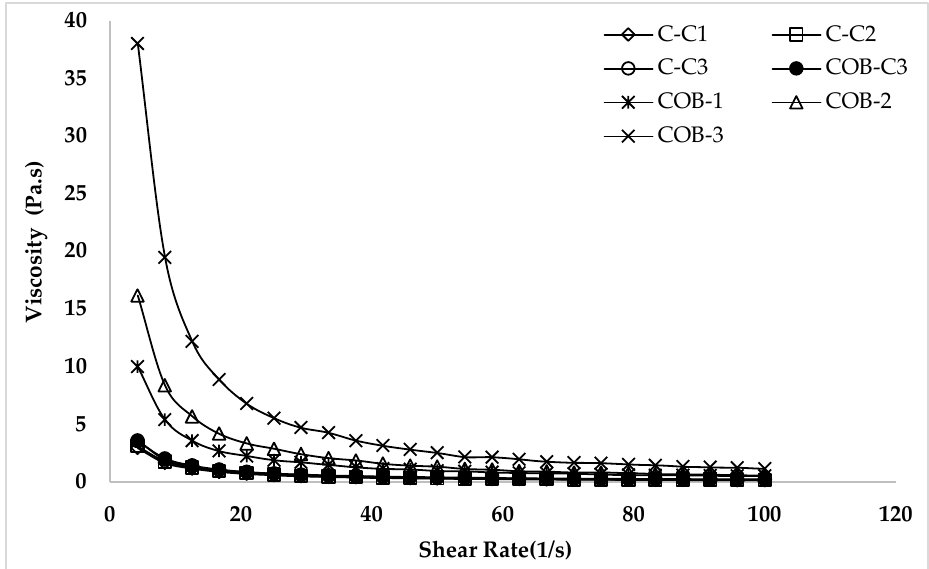
Figure 2. The steady shear rheological properties of ice cream mixes.